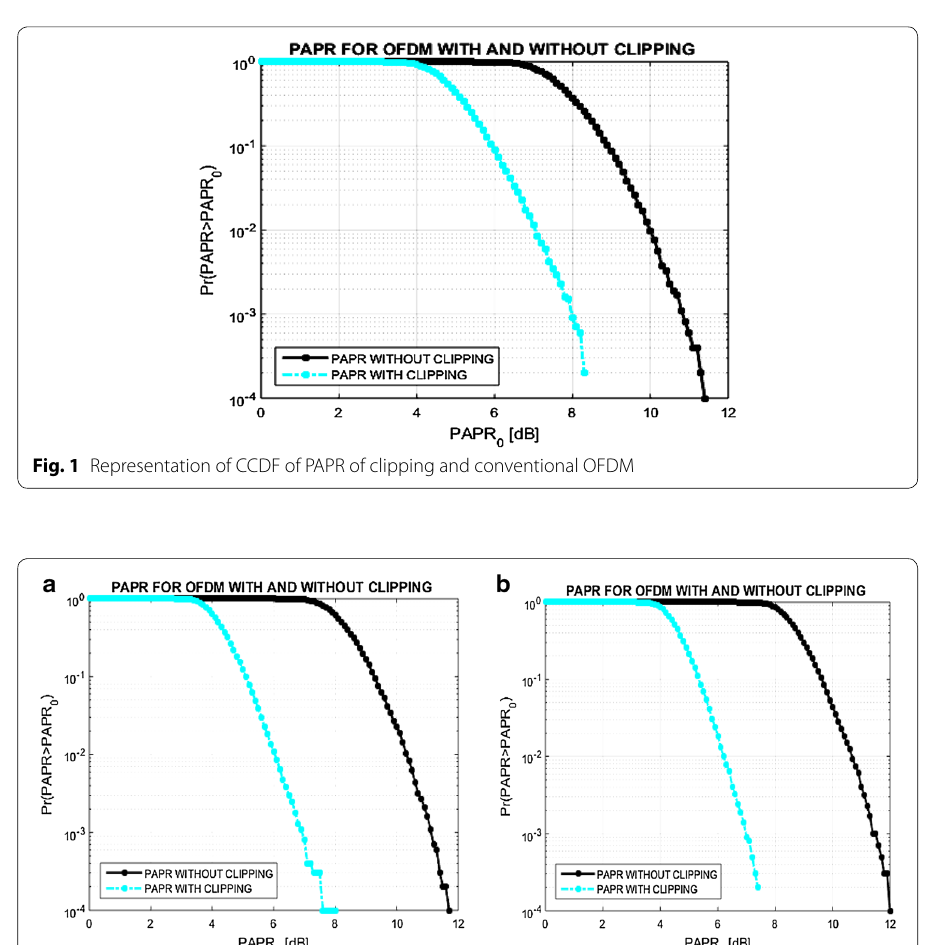
512; b number of subcarriers =